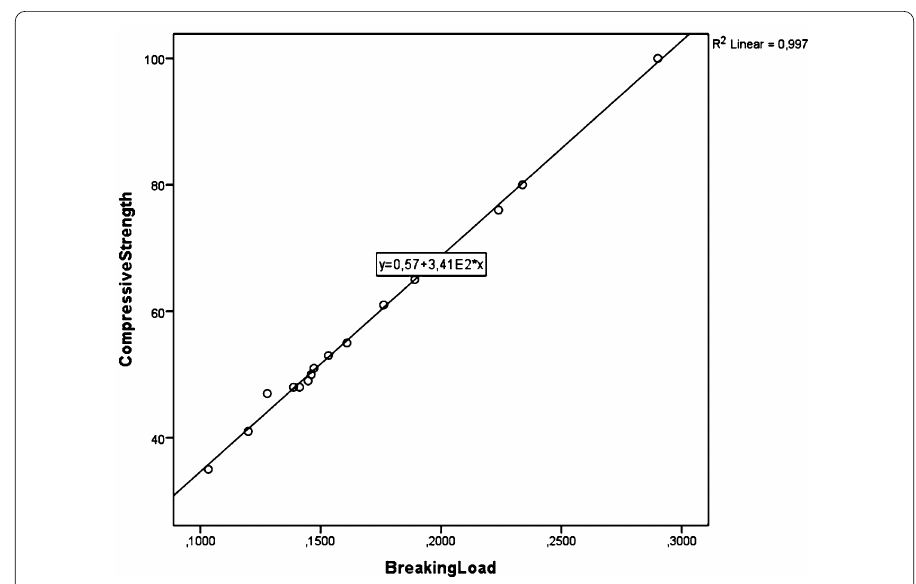
Figure 3 The linear distribution plot of the physical and physical and mechanical properties of load-compressive strength